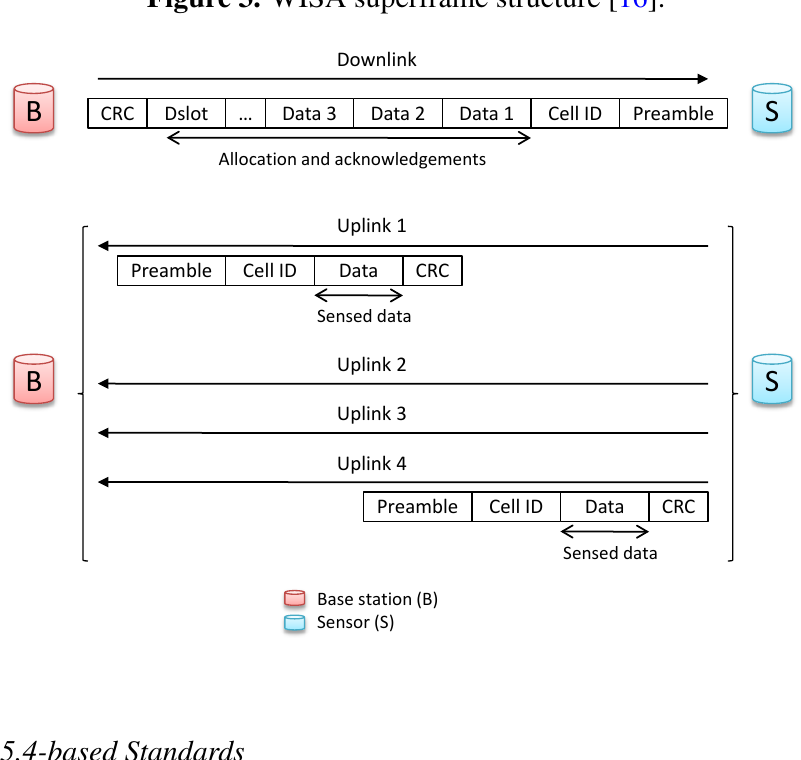
Figure 3. WISA superframe structure [16].